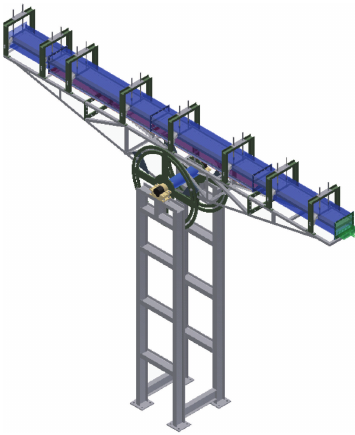
Figure 3: Decay heat removal test facility at NPIC [12].